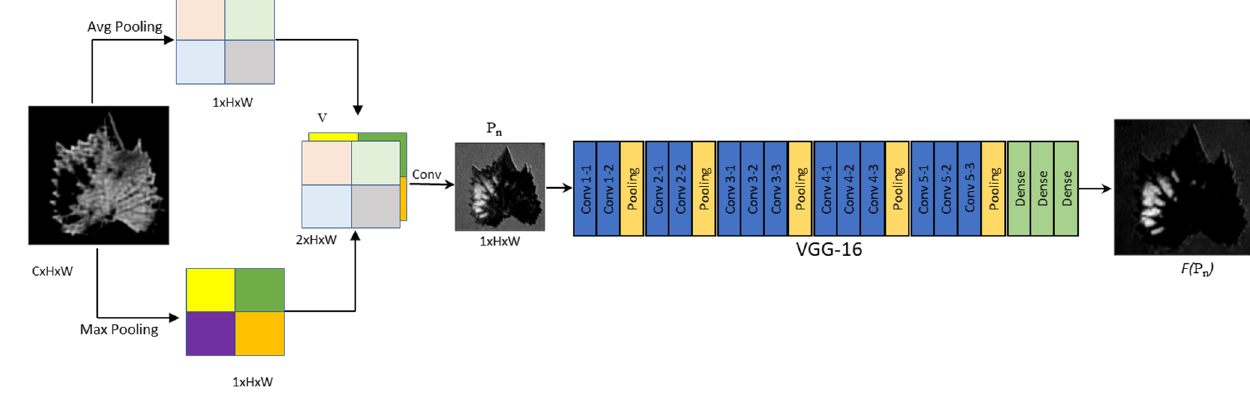
Figure 4. Spatial attention mechanism.